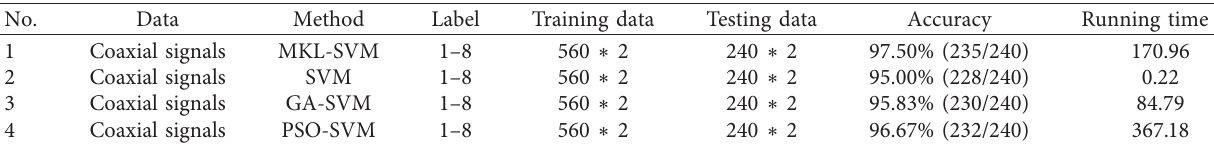
Table 7: Results of MKL-SVM and